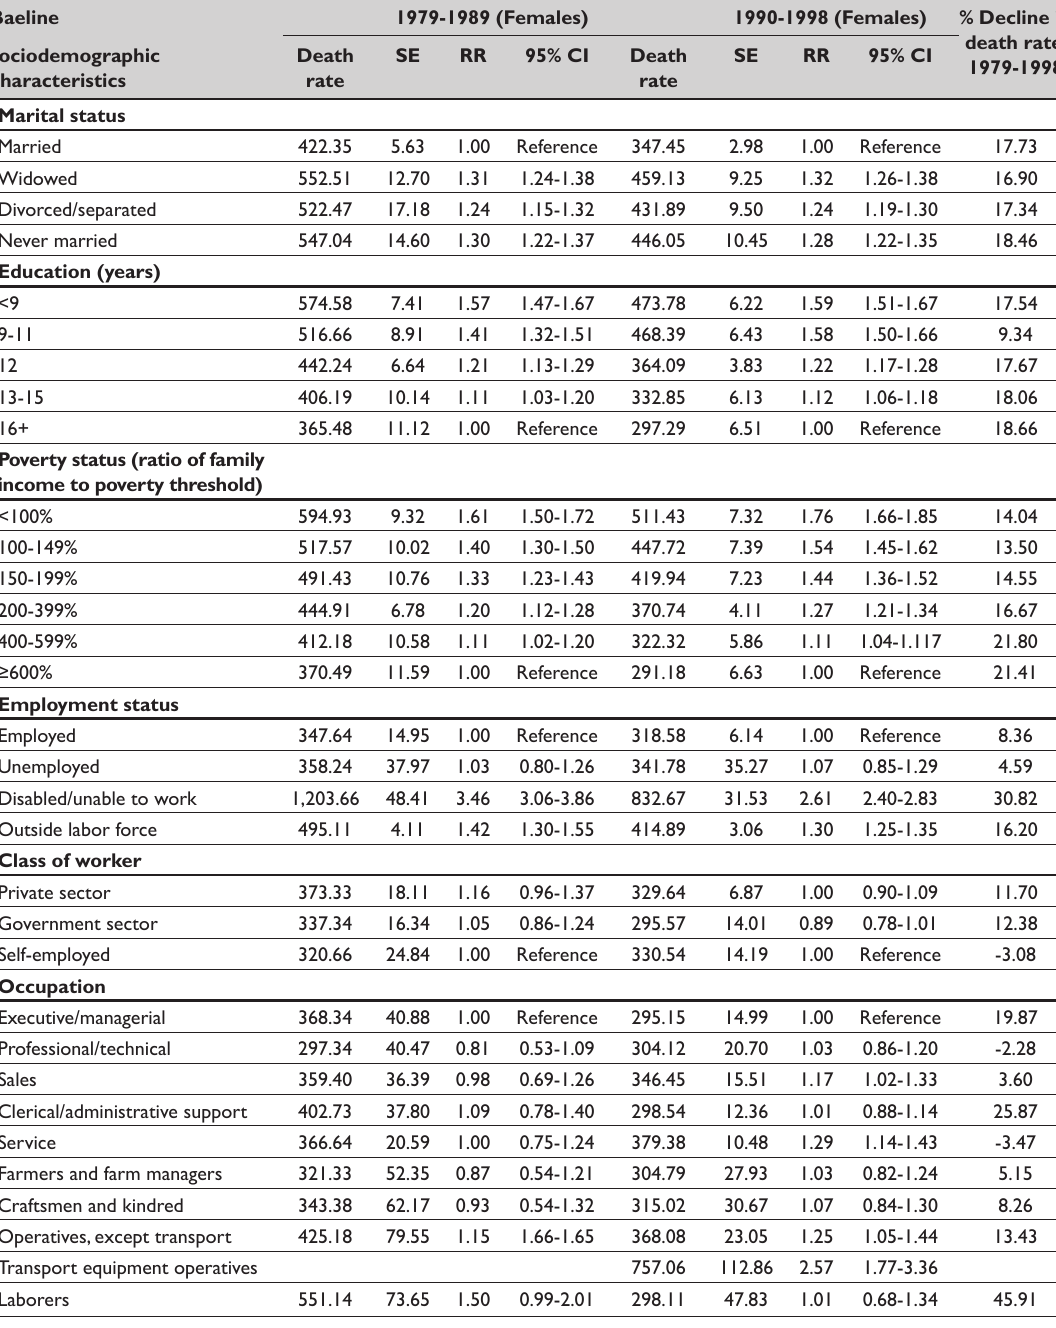
Table 2. Age-Adjusted Death Rates per 100,000 Person-Years of Exposure and Relative Risks of Cardiovascular Disease (CVD) Mortality Among US Females Aged 25+ Years: The National Longitudinal Mortaliy Study, 1979-1998